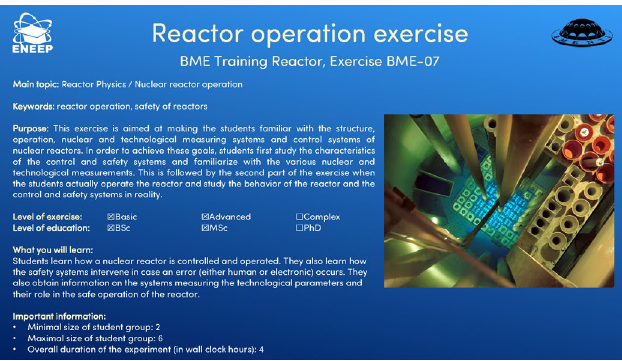
Fig. 8. Example of experiment presentation materials – BME, Reactor operation exercise.